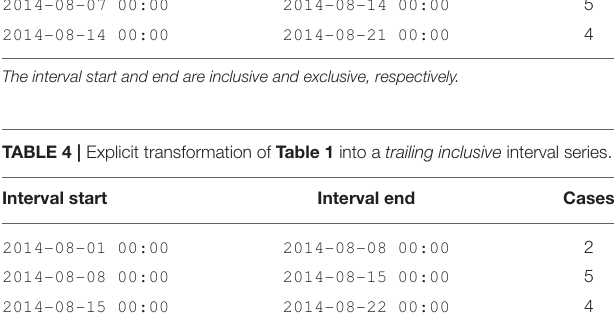
TABLE 3 | Explicit transformation of Table 1 into a trailing exclusive interval series. Interval start Interval end Cases